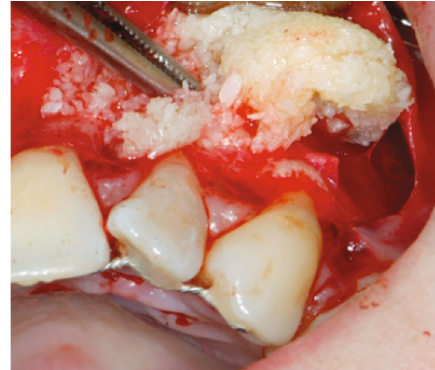
Figure 8: Positioning of the membrane.